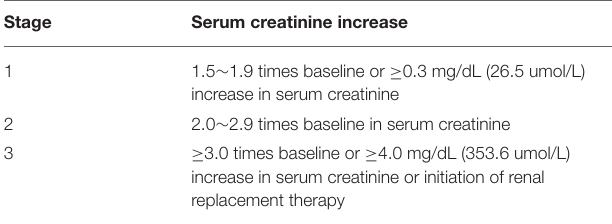
TABLE 1 | Stage of post-operative AKI in ADIAD using modified KDIGO criteria.